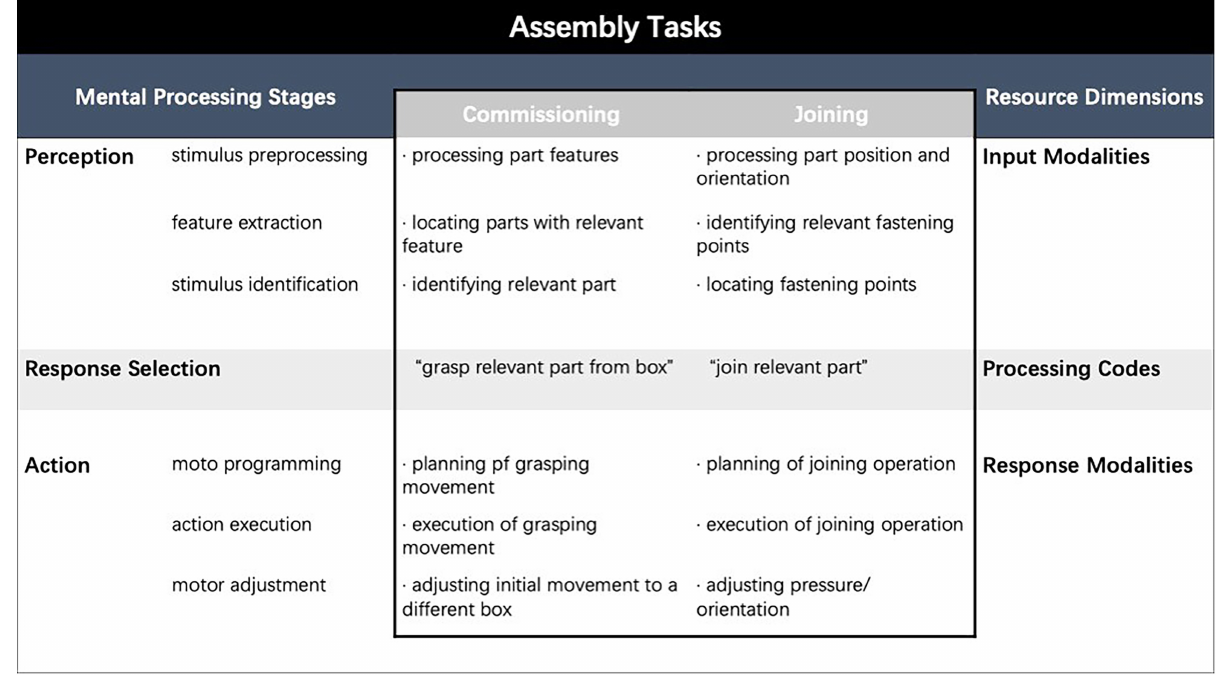
FIGURE 1 | Information processing framework of assembly